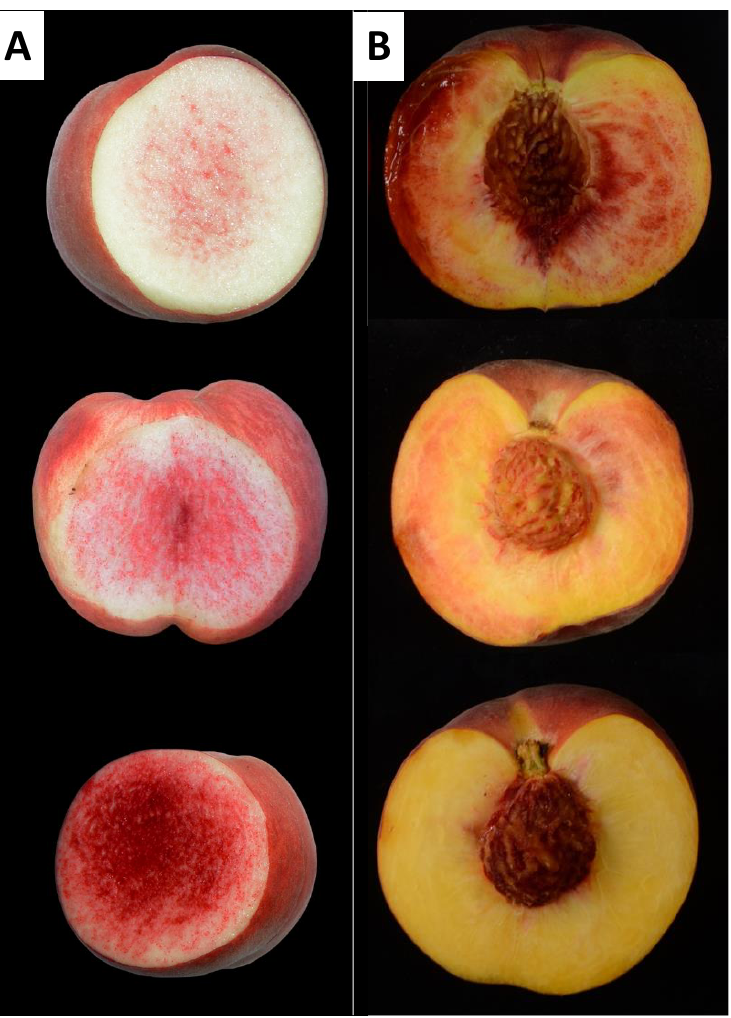
Figure 4. Images of three different individuals from the BbxNl ( A ) and SDF2 ( B ) populations showing the different intensities of the RDF phenotype.